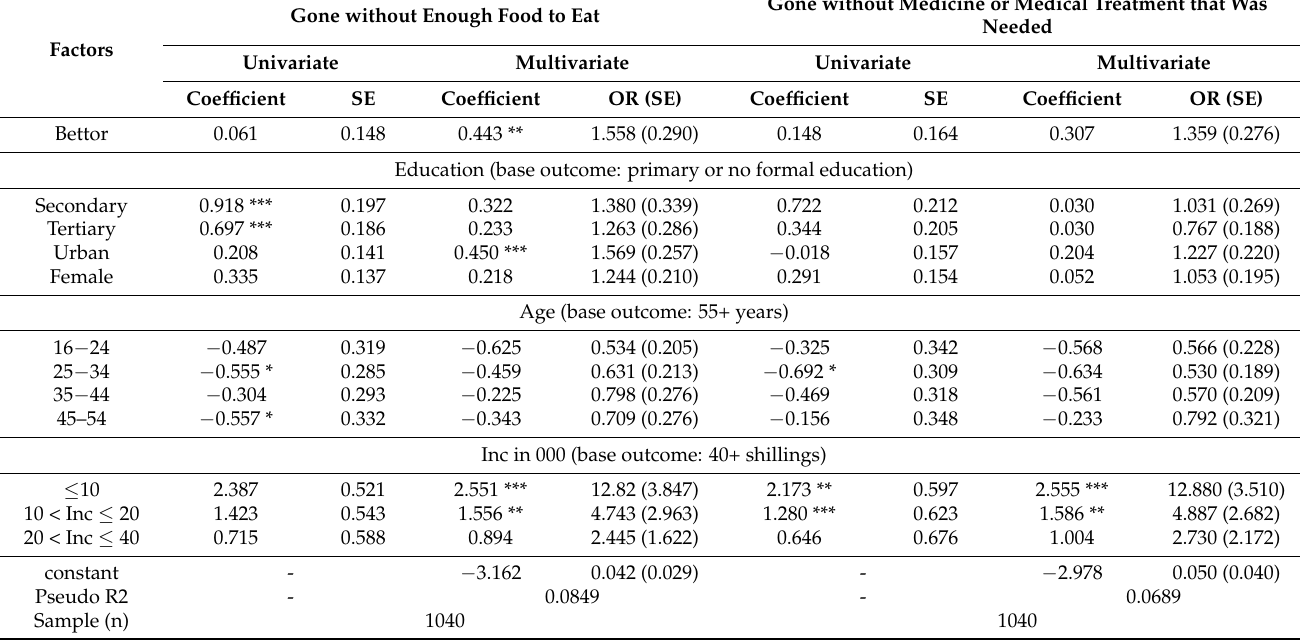
Table 5. Association between betting and welfare